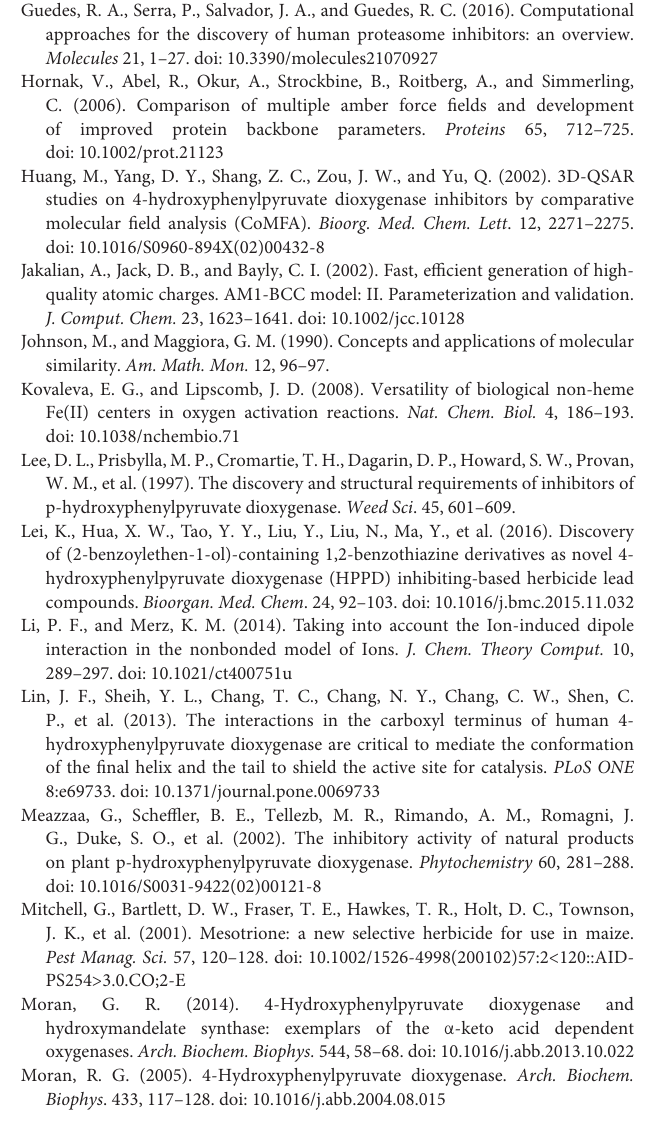
Figure S1 | Structures of the most representative triketone HPPD